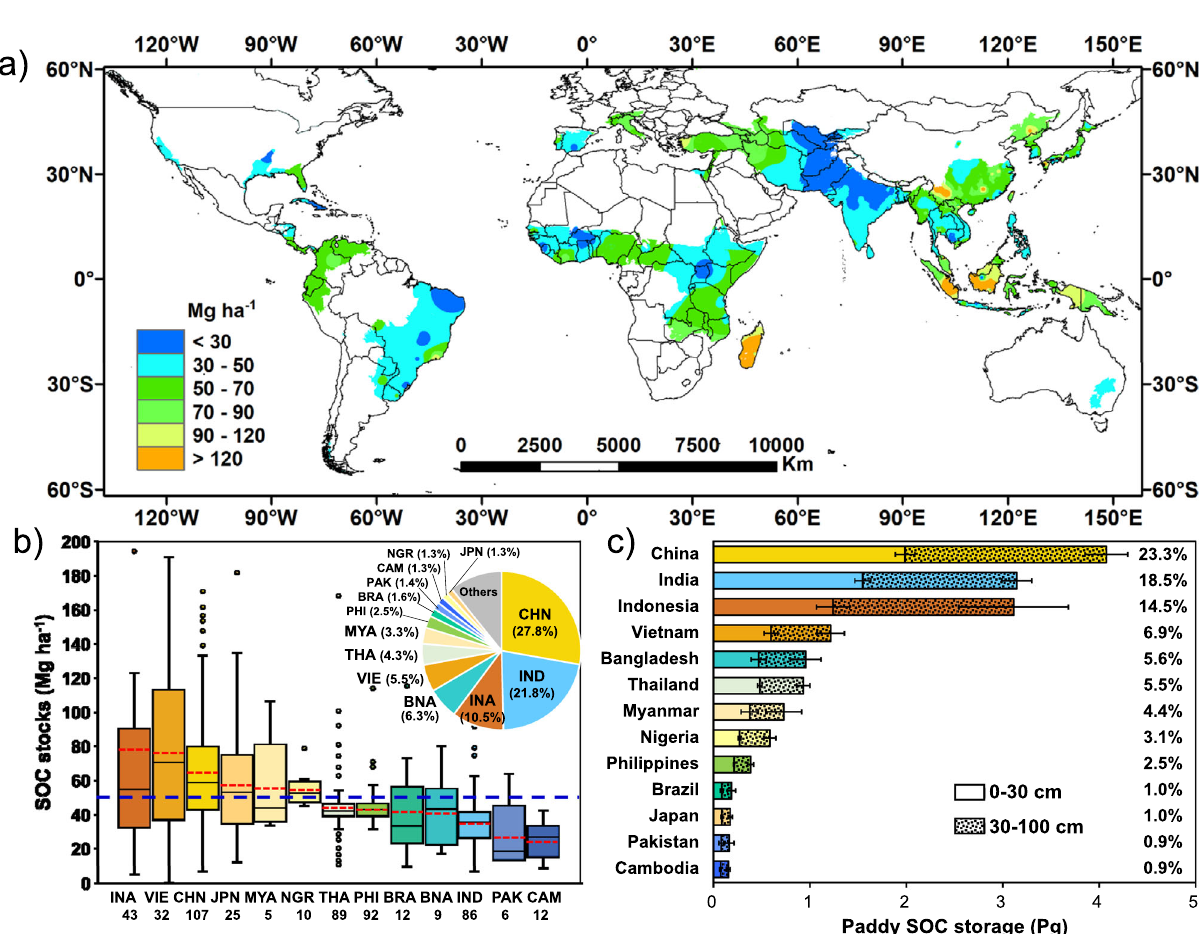
Fig. 2 Map view and soil organic C stocks of the main rice-producing countries. a Spatial distribution of SOC stocks in paddy topsoil (0 – 30 cm). b Boxplots of SOC stocks in the topsoil (0 – 30 cm) of the 13 countries. Upper and lower bars: 95th and 5th percentiles of all observations, respectively; top and bottom of boxes: third and fi rst quartiles; black horizontal solid lines in boxes: median values; red dashed lines: mean values. Blue dashed lines indicate global average SOC stock (51 Mg ha − 1 ). The embedded pie chart shows the percentage contribution of each country to global rice production. Countries are arranged by decreasing mean SOC stocks per ha: INA Indonesia, VIE Vietnam, CHN China, JPN Japan, MYA Myanmar, NGR Nigeria, THA Thailand, PHI Philippines, BRA Brazil, BNA Bangladesh, IND India, PAK Pakistan, CAM Cambodia. The numbers below the x -axis indicate the number of datapoints for each country. Three datapoints for Indonesia fell outside the y -axis; these data were included in SOC stock calculations. c Total paddy SOC stocks in the topsoil (0 – 30 cm) and the 100 cm pro fi le in the 13 countries. The contributions of paddy SOC stocks (0 – 100 cm) to the global paddy SOC stock for each country are shown as percentages. Error bars indicate standard errors